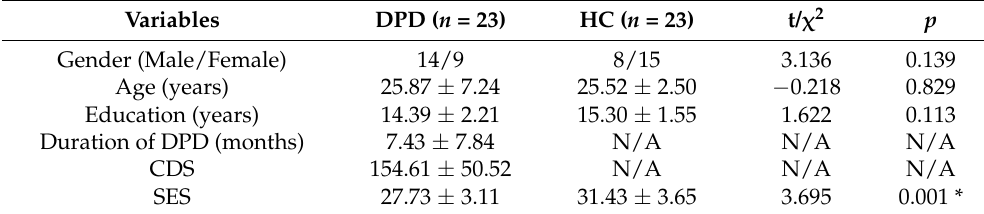
Table 1. Demographic information and clinical data in DPD patients and the HC. Variables